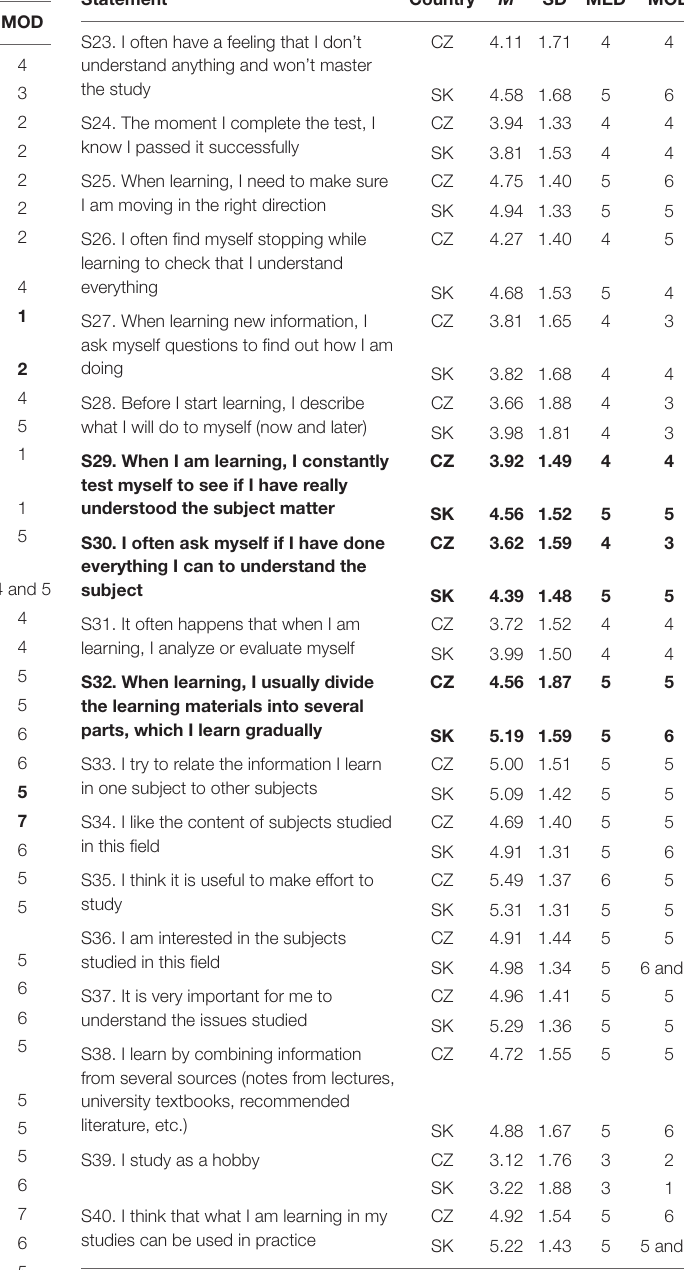
TABLE 2 | Descriptive statistics of items included in the research questionnaire by